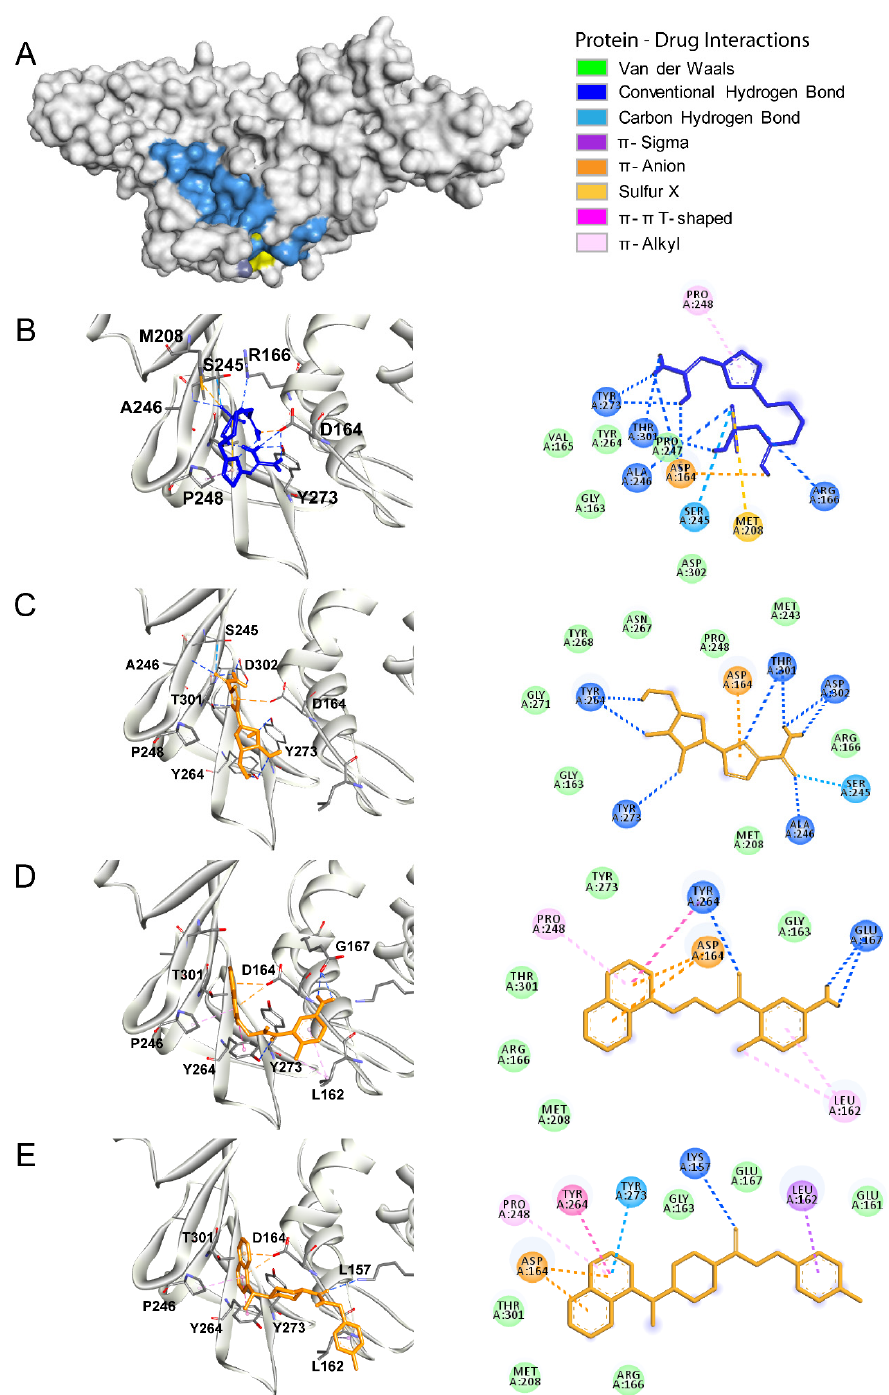
Figure 2. The SARS-CoV2 papain-like protease (PLpro) as a drug target. ( A ) The surface representation of the SARS-CoV2 PLpro crystal structure (PDB ID: 6WUC). The catalytic site is shown in blue and the catalytic triad is shown in yellow. ( B – E ) Molecular docking of famotidine, ribavirin, compound SARS-CoV(1), and compound SARS-CoV(2), respectively, into the catalytic site of the SARS-CoV2 PLpro. The 3D structures of the protein–drug complexes are shown on the left. The protein is represented in ribbon, and drug ligands are shown as sticks. Famotidine is shown in dark blue, while ribavirin, compound SARS-CoV(1), and compound SARS-CoV(2) are shown in orange. The main interacting residues are also indicated. The 2D diagrams of the main interaction networks between the drug ligand and the residues within the protease active site are shown on the right. The specific types of interactions are indicated in the legend. The final 3D structures and 2D diagrams of the protein–drug complexes were visualized with the Biovia Discovery Studio Visualizer 17.2.0